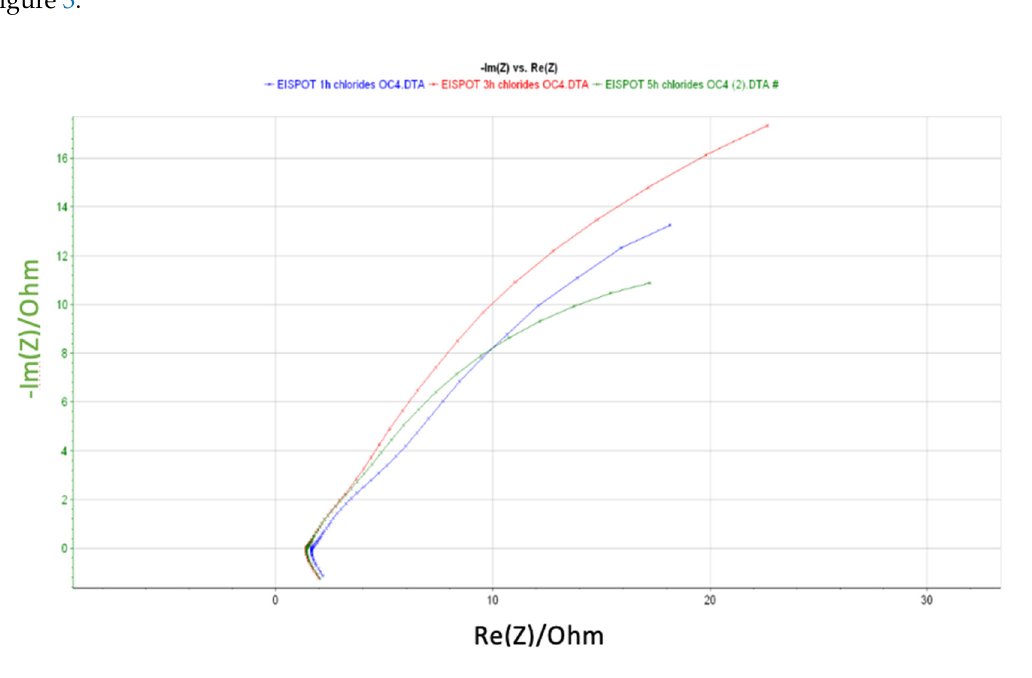
Figure 2. Nyquist diagram of alloy OC4 immersed in ternary chloride molten salt for 1, 3, and 5 h. Table 3. Electrochemical parameters obtained from electrochemical impedance spectroscopy (EIS) tests of OC4.